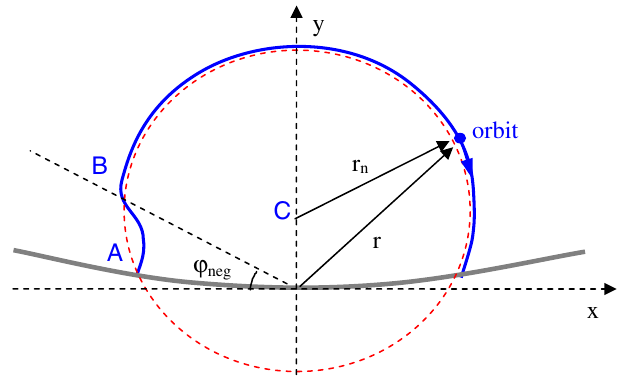
FIG. 2. A typical trajectory showing the orbit center C and (cid:1) . The iris curvature has been exaggerated for illustrative neg